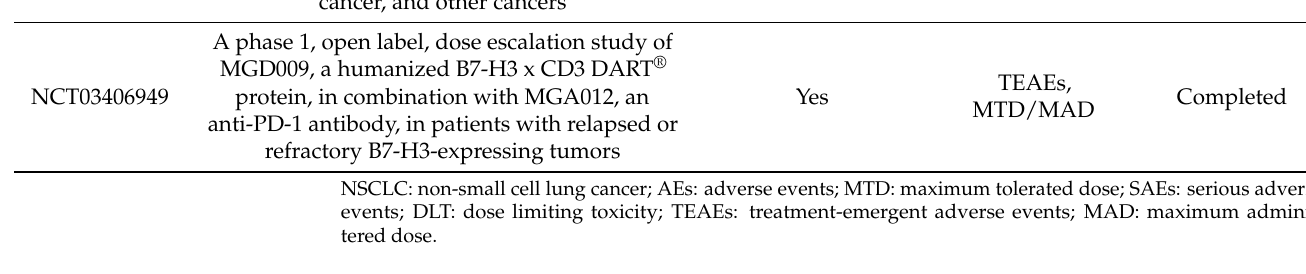
Table 3. Available clinical results on B7-H3 inhibitors in NSCLC.